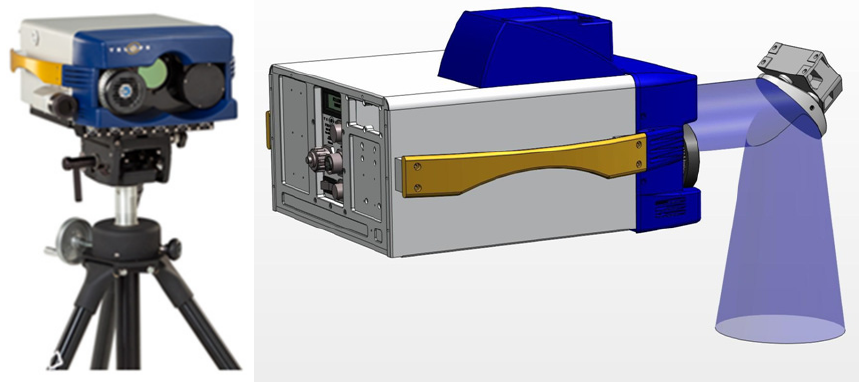
Figure 1. Hyper-Cam-LW Sensor ( left ) and instrument setup for ground measurements ( right